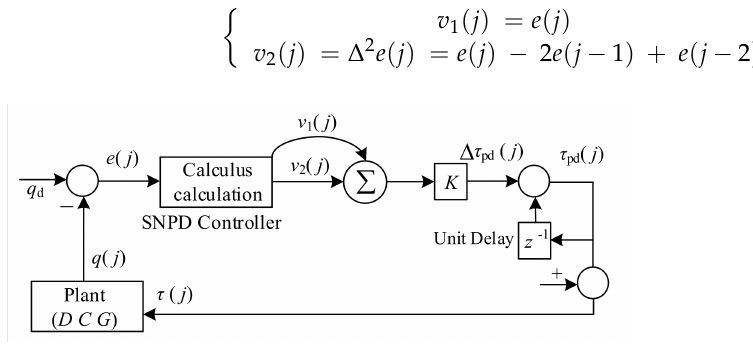
Figure 2. The control flow illustration of